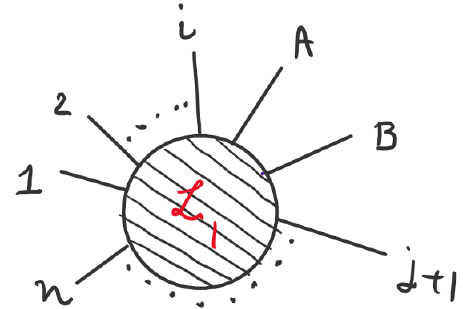
Figure 4 . The left